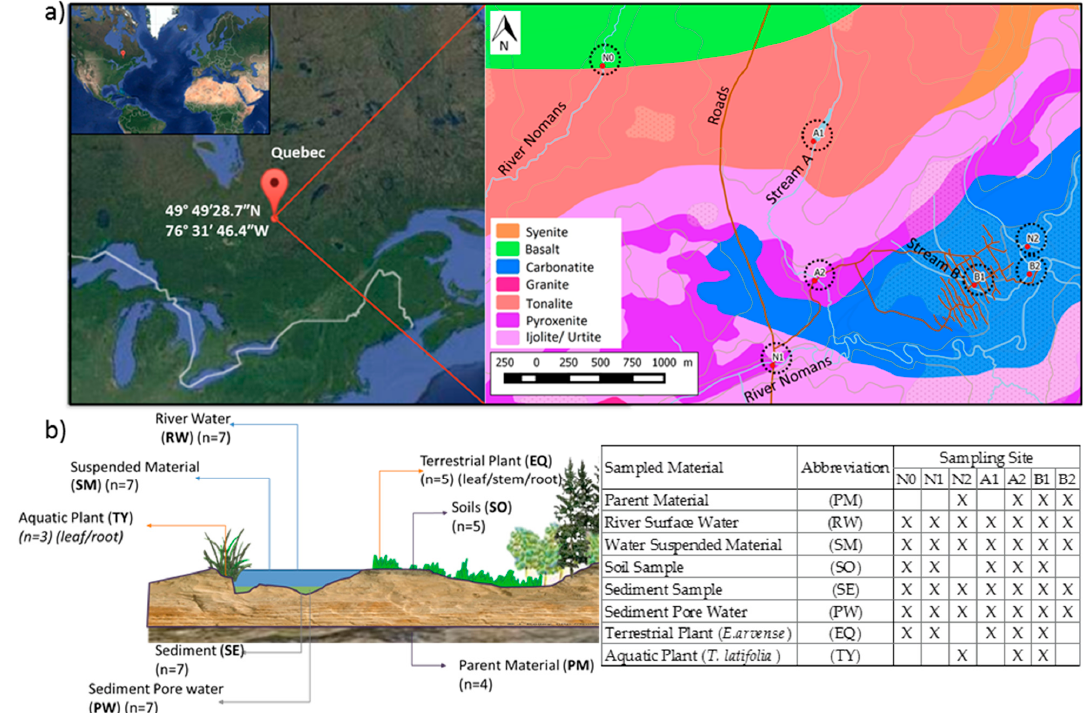
Figure 1. ( a ) Geographical location of the Montviel area (source: Google Earth) and simplified geological map (provided by GéoMégA Resources Inc.) with the locations of the seven sampling sites in the different watercourses; ( b ) graphical representation of the sampled materials with their abbreviations and a description of the number of samples and where they were collected.